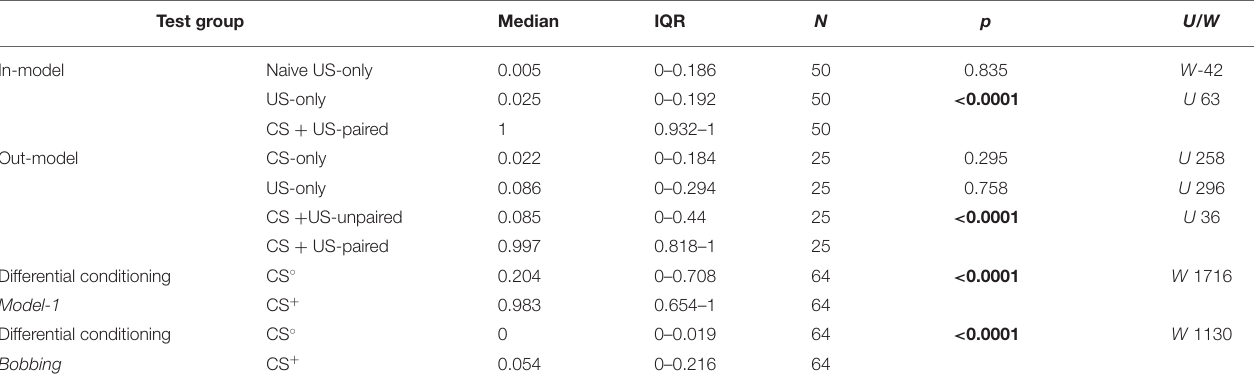
TABLE 3 | P resp values for all test groups of animals used to construct (in-model) and test (out-model) the binary logistic regression Model-1, and also for the differential conditioning paradigm ( Model-1 , bobbing